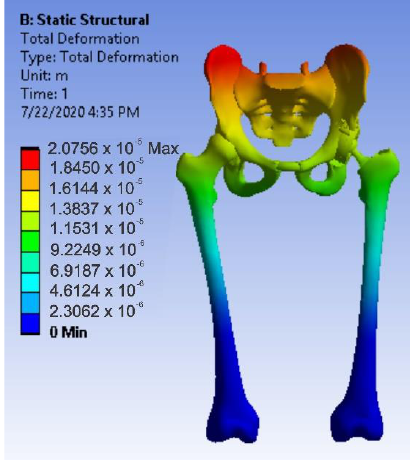
Diagnostics 2022 , 12 , x FOR PEER REVIEW Figure 41. Displacement map for revision prosthesis with titanium augment. Figure 41. Displacement map for revision prosthesis with titanium augment.